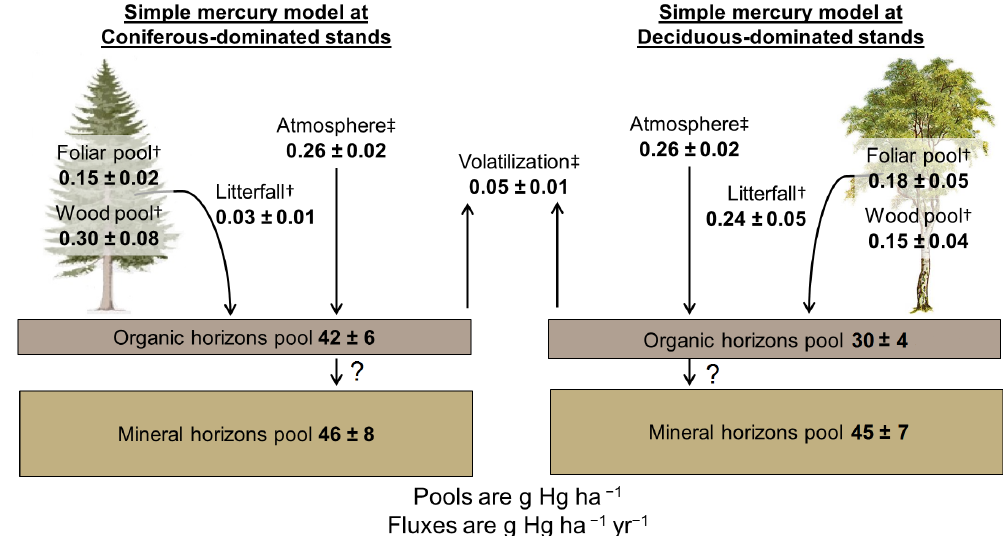
Figure 5. Total Hg pools in foliage, wood, organic horizons, and mineral horizons at conifer- and deciduous-dominated forest stands. See Sect. 2.5 for explanation of flux estimates. Mean values are given ± 1 standard error. † Litterfall was estimated using foliar pools and senescence rates for each genus. ‡ Atmospheric deposition and volatilization rates were interpolated from Miller et al. (2005) and Yu et al.